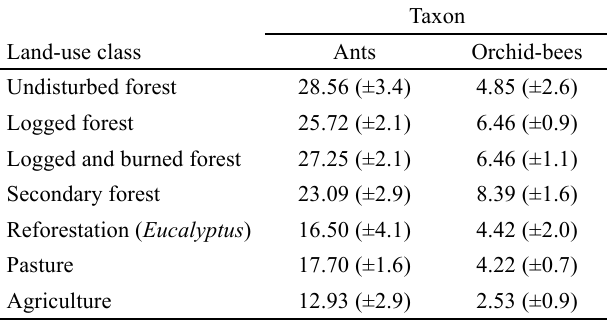
Table 1 . Average species richness ± confidence intervals for species richness of each taxon per transect in each land-use type.